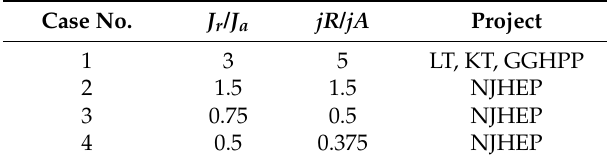
Table 4. Ratio of joint roughness and joint alteration rating based on Q and RMi systems for the four projects. Case